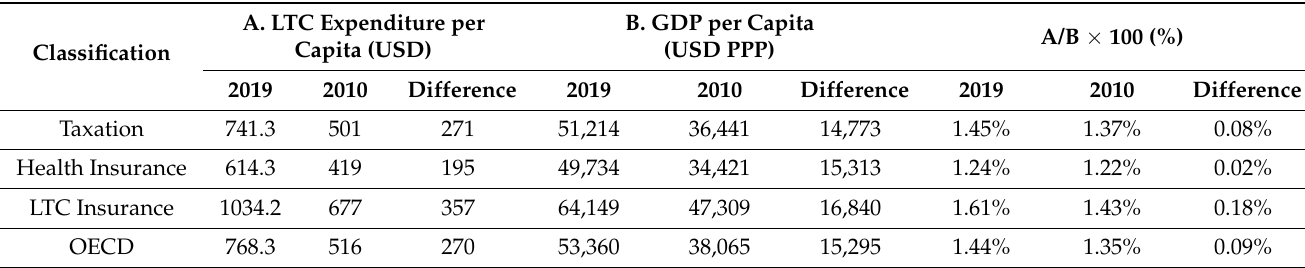
Table 6. Long-term care expenditure per capita (USD, PPP) as a percentage of GDP per capita (2019)